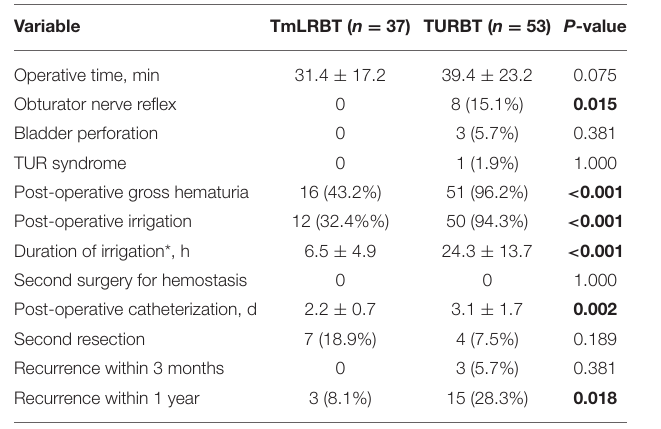
FIGURE 1 | The K-M curve of recurrence-free survival of the patients who underwent TmLRBT or